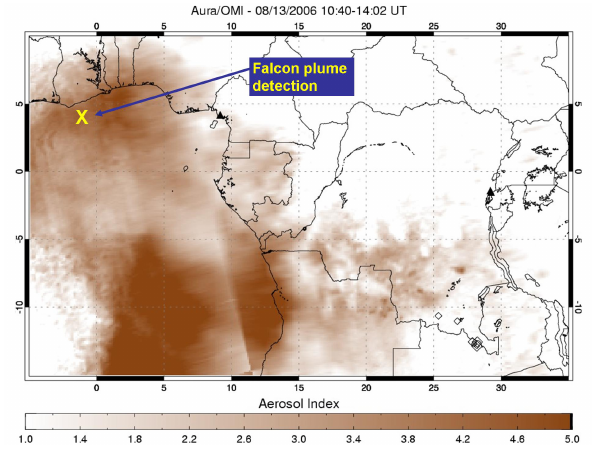
Fig. 2. Aerosol Index AI of light absorbing aerosols measured by OMI on Satellite AURA on the 13 August 2006.